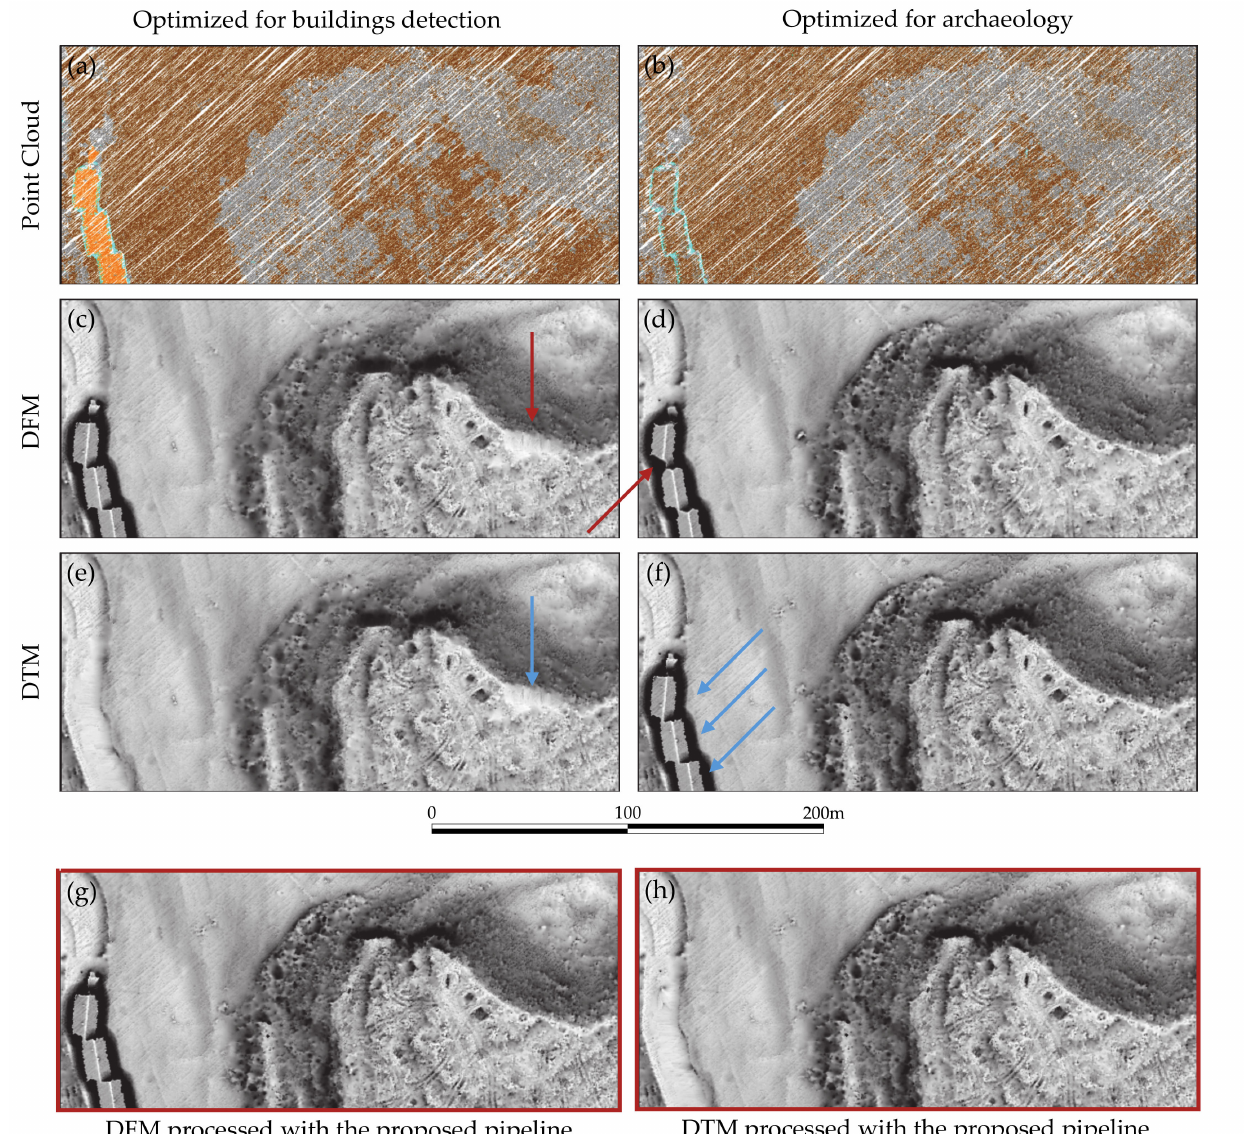
Figure 14. Test site SI1, automatic ground point and object-type classification: ( a )—-classified point cloud after building- detection-optimized processing; ( b )—classified point cloud after archaeological-feature-detection-optimized processing (both: brown–ground points; orange–modern buildings; grey–unclassified; turquoise- noise); ( c )—DFM after building- detection-optimized processing; ( d )—DFM after archaeological-feature-detection-optimized processing; ( e )—DTM after building-detection-optimized processing; ( f )—DTM after archaeological-feature-detection-optimized processing; ( g )—DFM processed with the proposed pipeline; ( h )—DEM processed with the proposed pipeline; red arrows: DFM deficiencies; blue arrows: DTM deficiencies. Processing other than indicated above: see Table